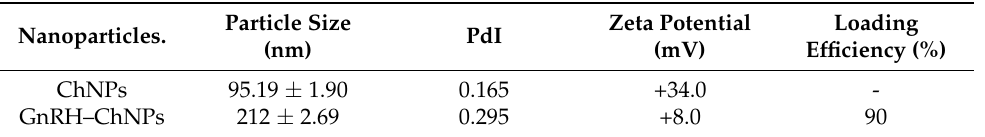
Table 1. Particle size, polydispersity index (PdI), zeta potential, and loading efficiency of chitosan